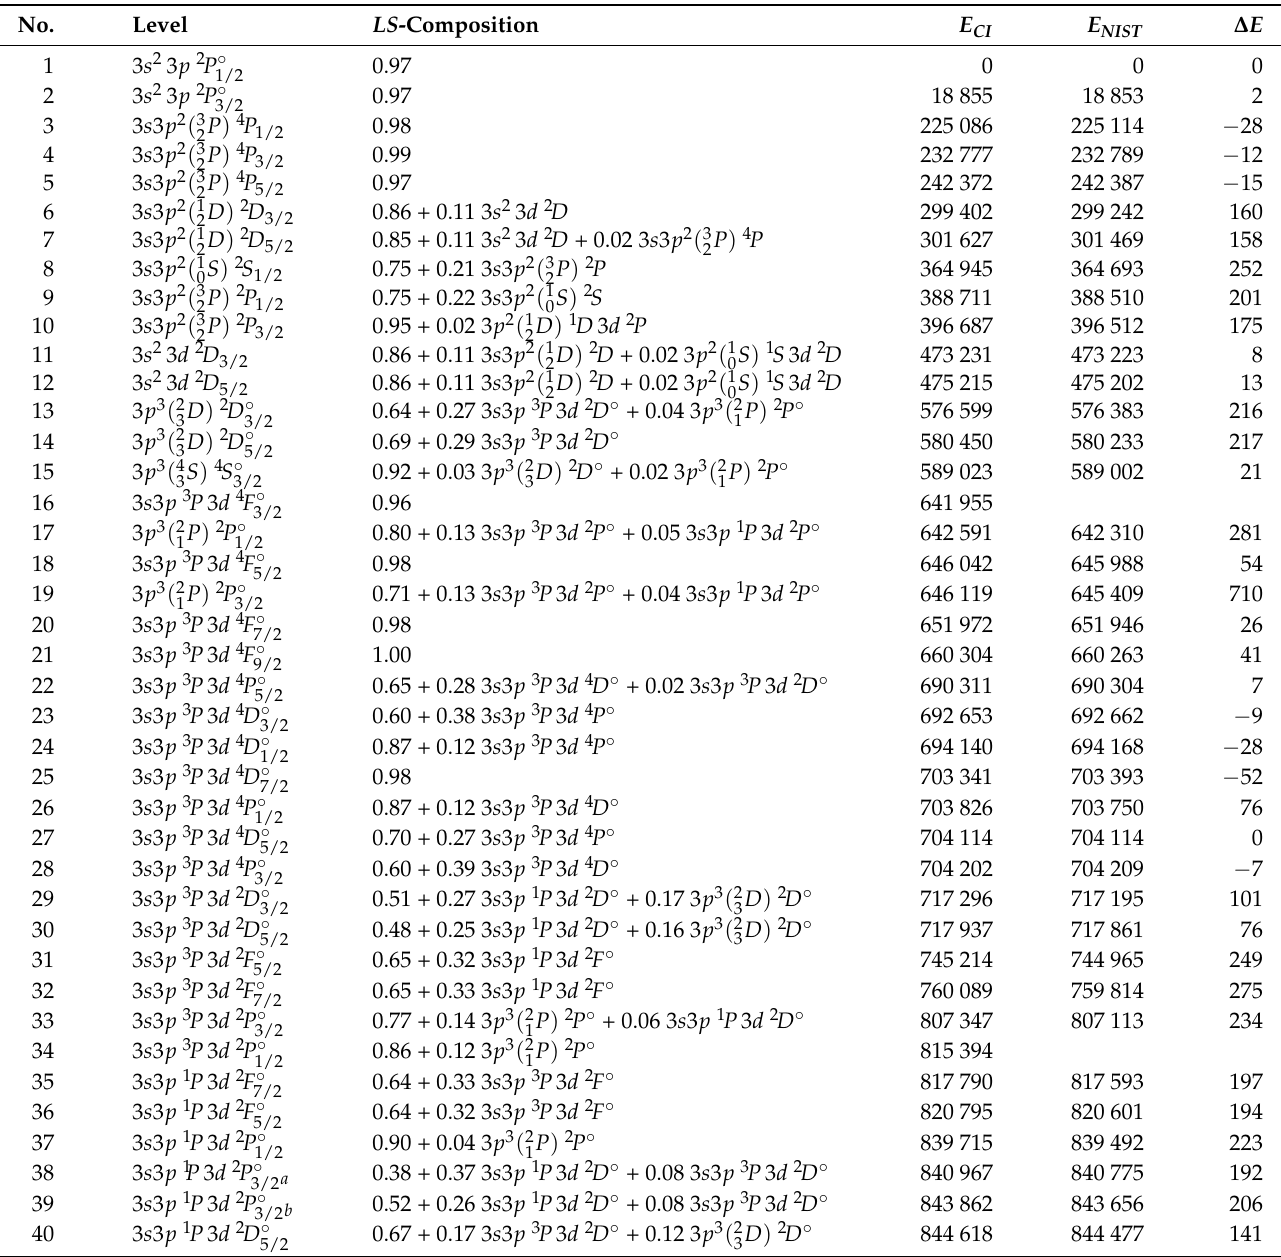
Table 7. Energies in cm − 1 and LS -compositions for the first 40 levels in Fe XIV. E CI Ekman et al. [167], E NIST NIST Atomic Spectra Database (2013) [168] and ∆ E difference between E CI and E NIST . Indices “ a ” and “ b ” are used to differentiate between identical configurations which share the same coupling and leading LS -percentage composition. The first number in the LS -compositions is the expansion coefficient for the leading configuration and LSJ term in column